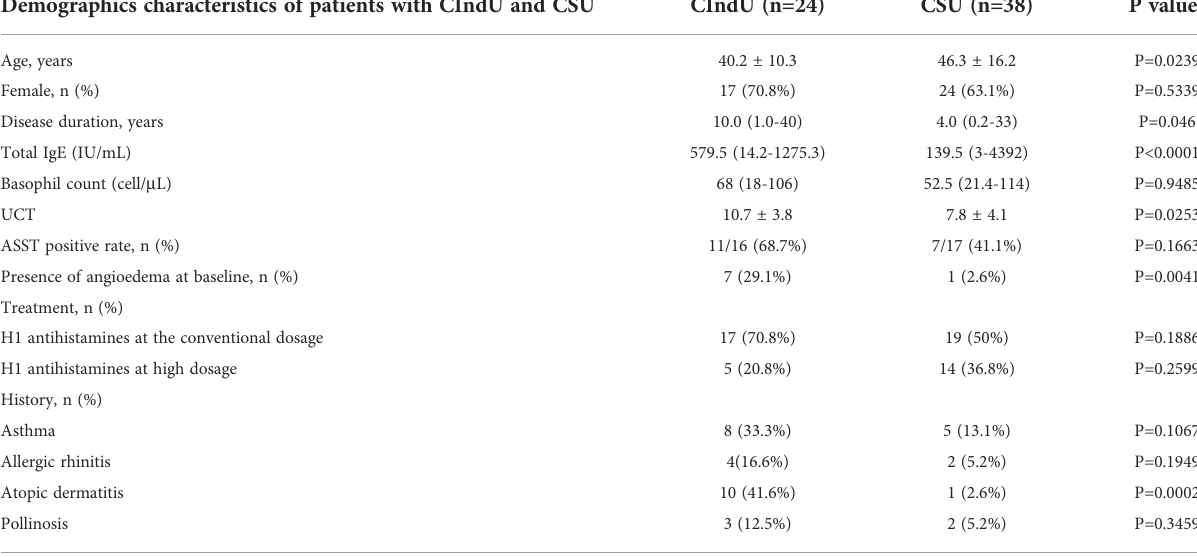
TABLE 1 Clinical and laboratory characteristics of patients with chronic inducible urticaria (CIndU) and chronic spontaneous urticaria (CSU). Demographics characteristics of patients with CIndU and